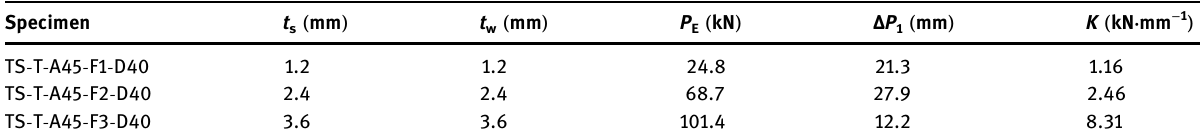
Table 9: The e ff ect of the thickness of the lattice Specimen